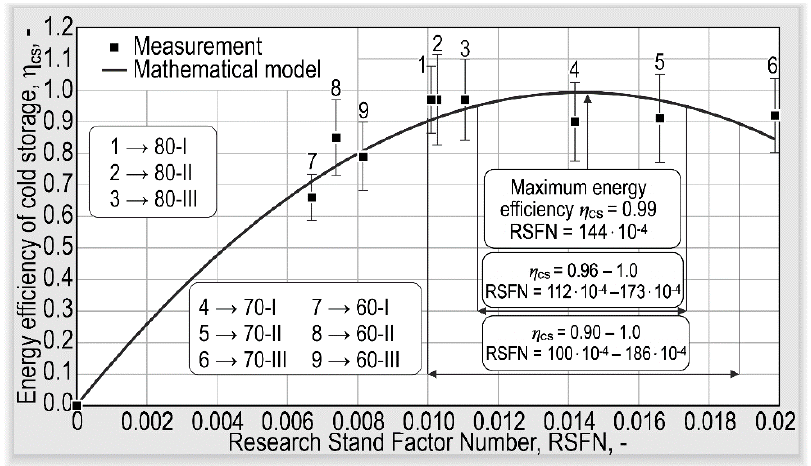
Figure 9. Distribution of measurement results and the values of the mathematical model of energy efficiency of cold storage as a function of the operation conditions of the prototype cold accumulator.